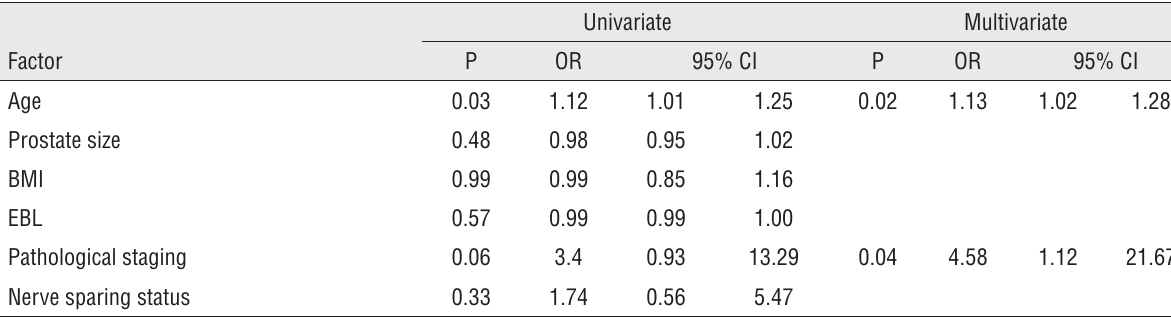
Table 7 - Logistic regression analyses of 3-month urinary continence factors.